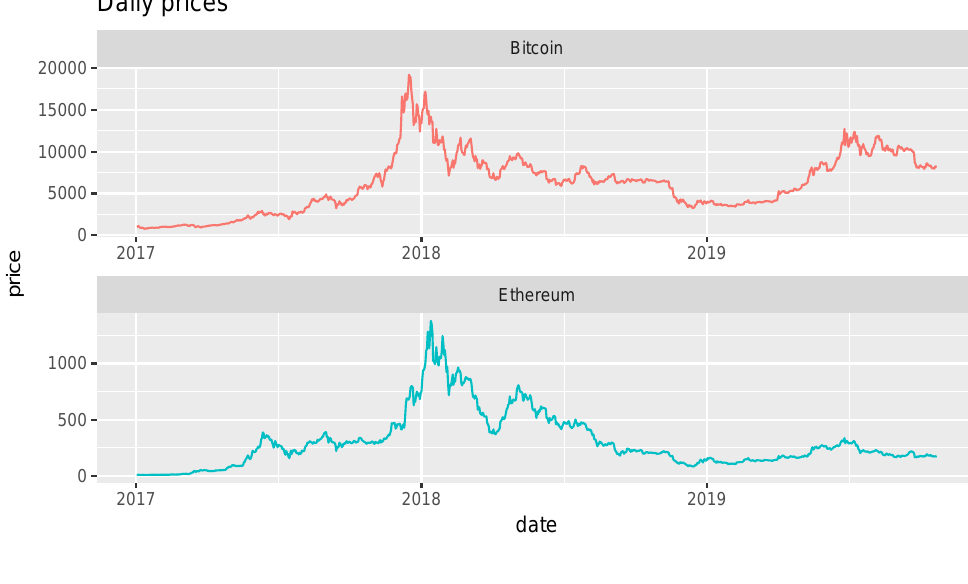
Figure 2: Time series of Bitcoin and Ethereum daily prices